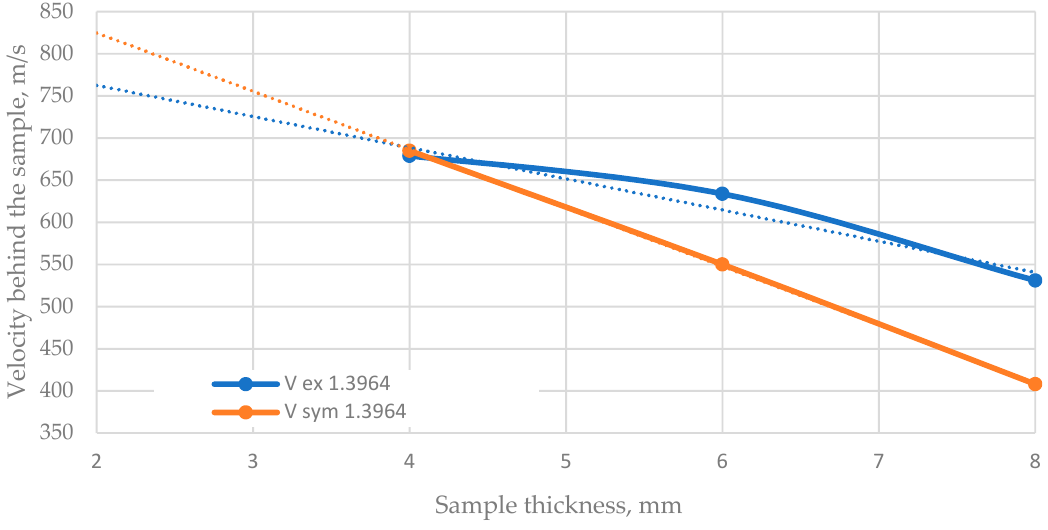
Figure 8. Comparison of projectile velocity results behind the samples of different thicknesses.